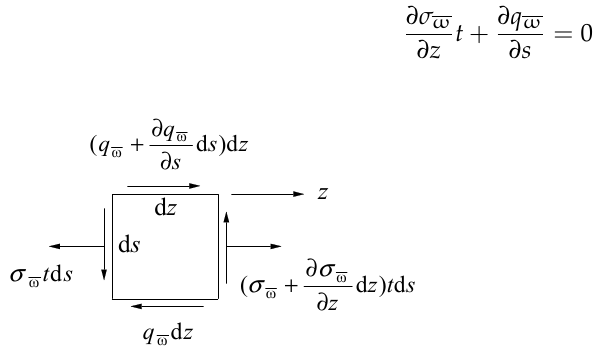
Figure 3. Stress diagram of the micro-element.